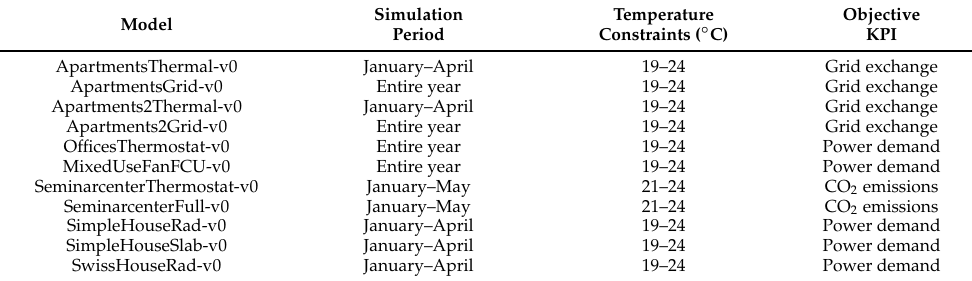
Table 2. Fixed evaluation scenarios for the simulation